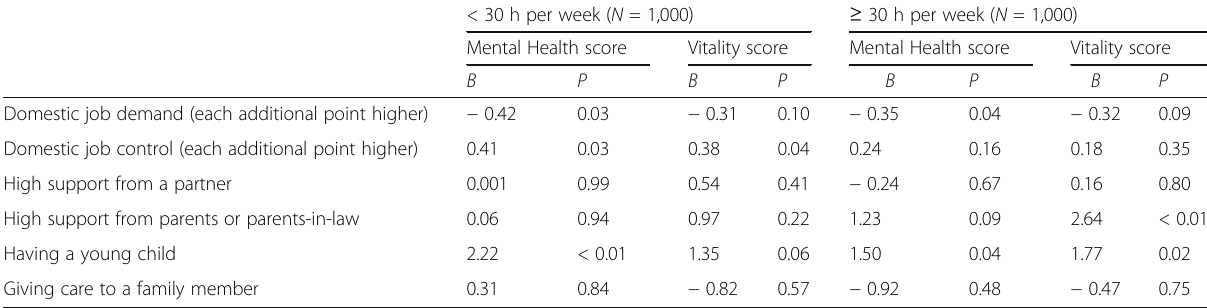
Table 3 Subgroup analyses of regression coefficient B a for domestic work factors to self-rated mental health by working